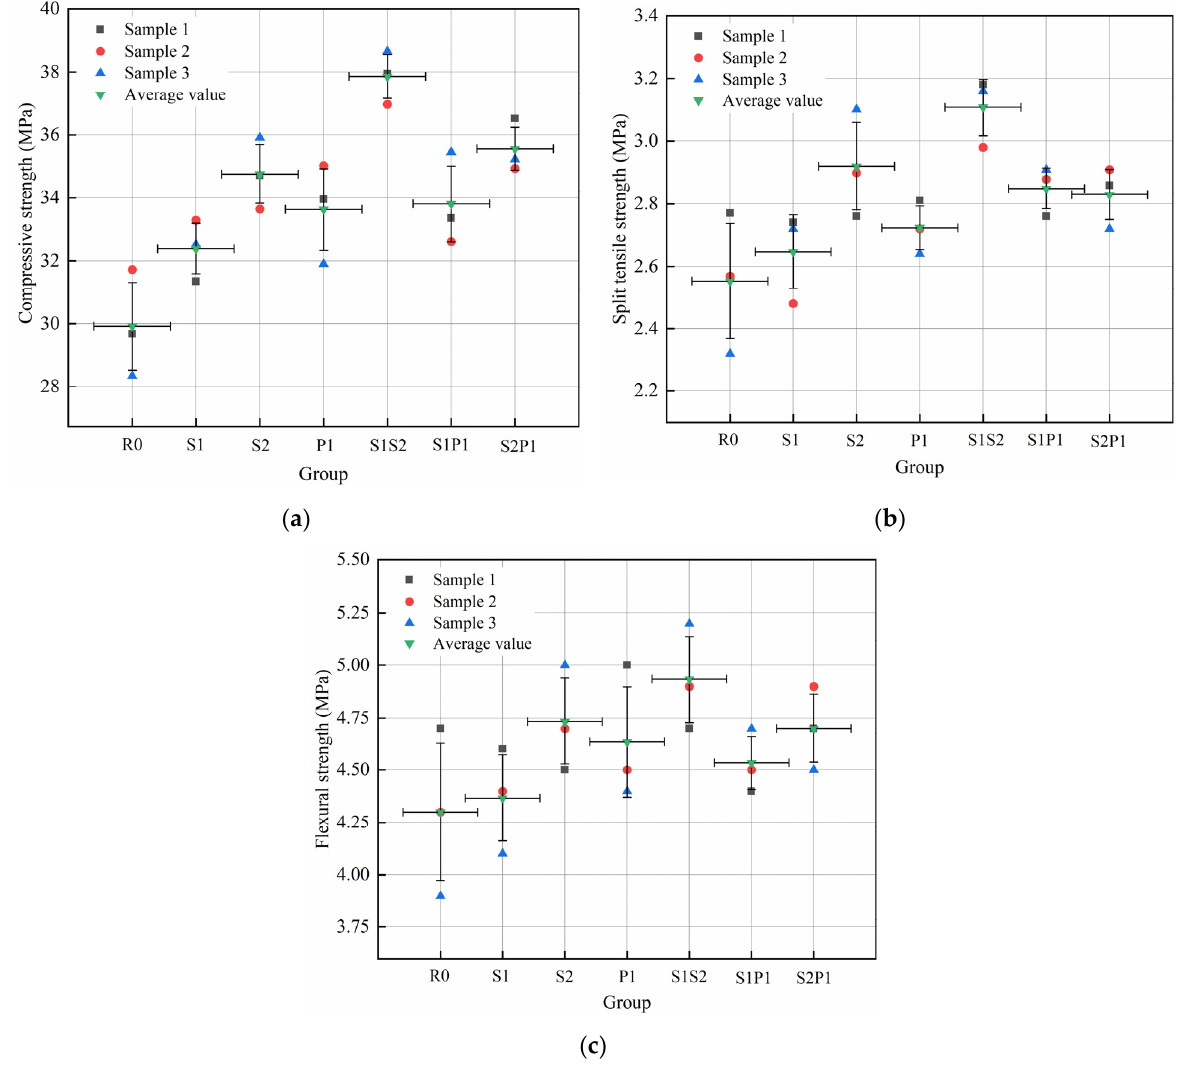
Figure 7. Mechanical properties of recycled aggregate concrete: ( a ) compressive strength; ( b ) splitting tensile strength; and ( c ) flexural strength.